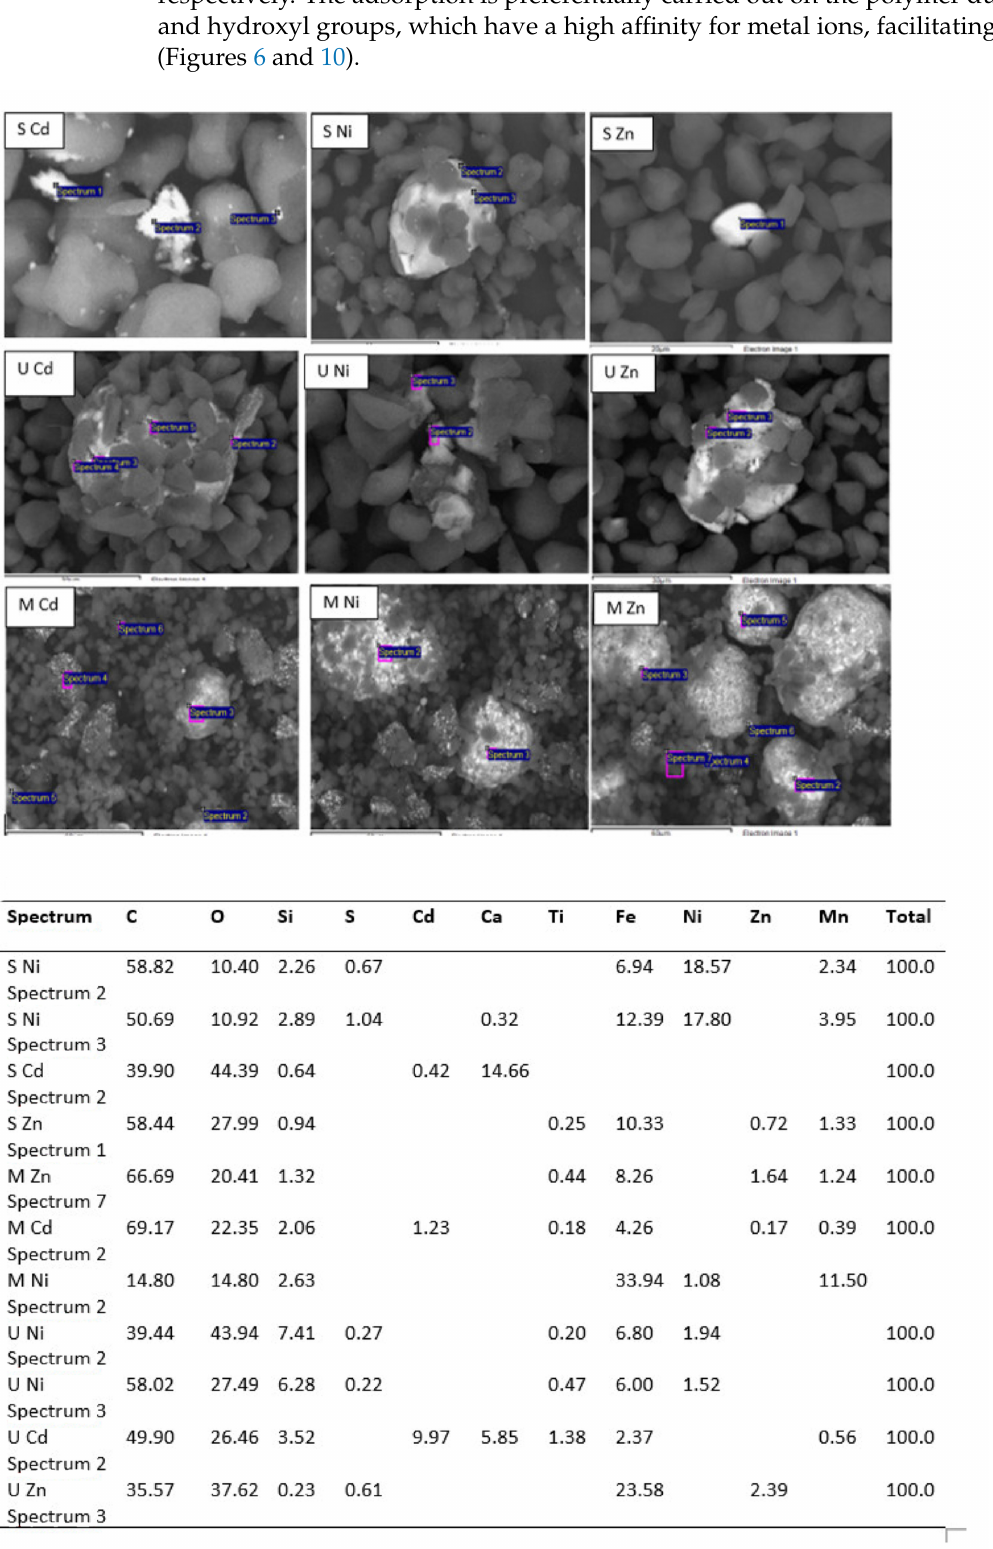
Figure 10. Mapping of metal removal onto WTP and EDX